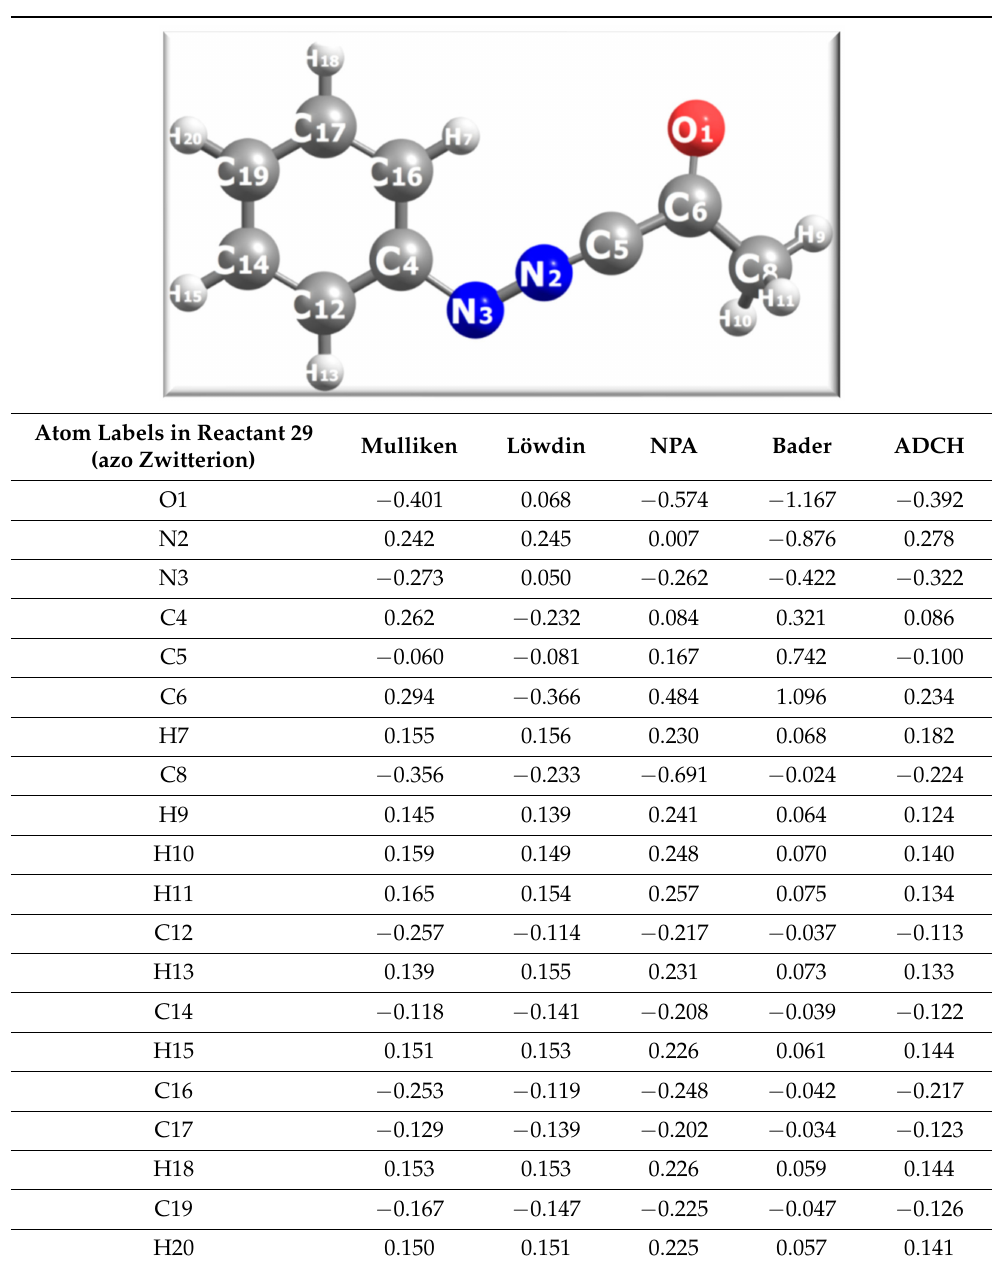
Table 1. Calculated atomic charges (in units of e ) for reactant 29 zwitterion computed at the B3LYP- D4/def2-TZVP level of theory in implicit ethanol as solvent. A ball-and-stick representation (grey color = C atoms, blue = N, red = O, white = H) with atom labels is